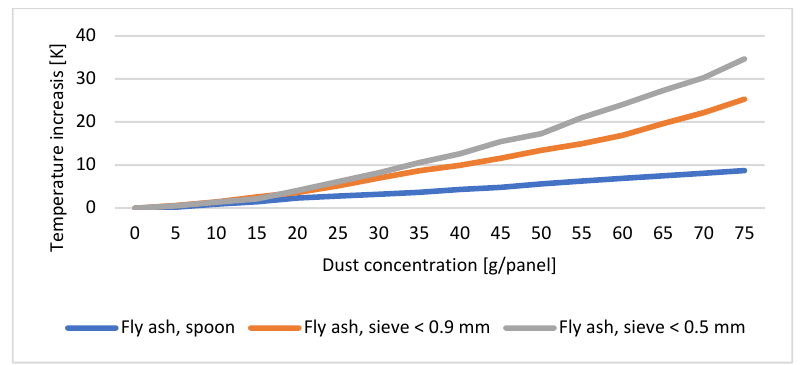
Figure 15. The temperature increase as a function of the fly ash concentration.